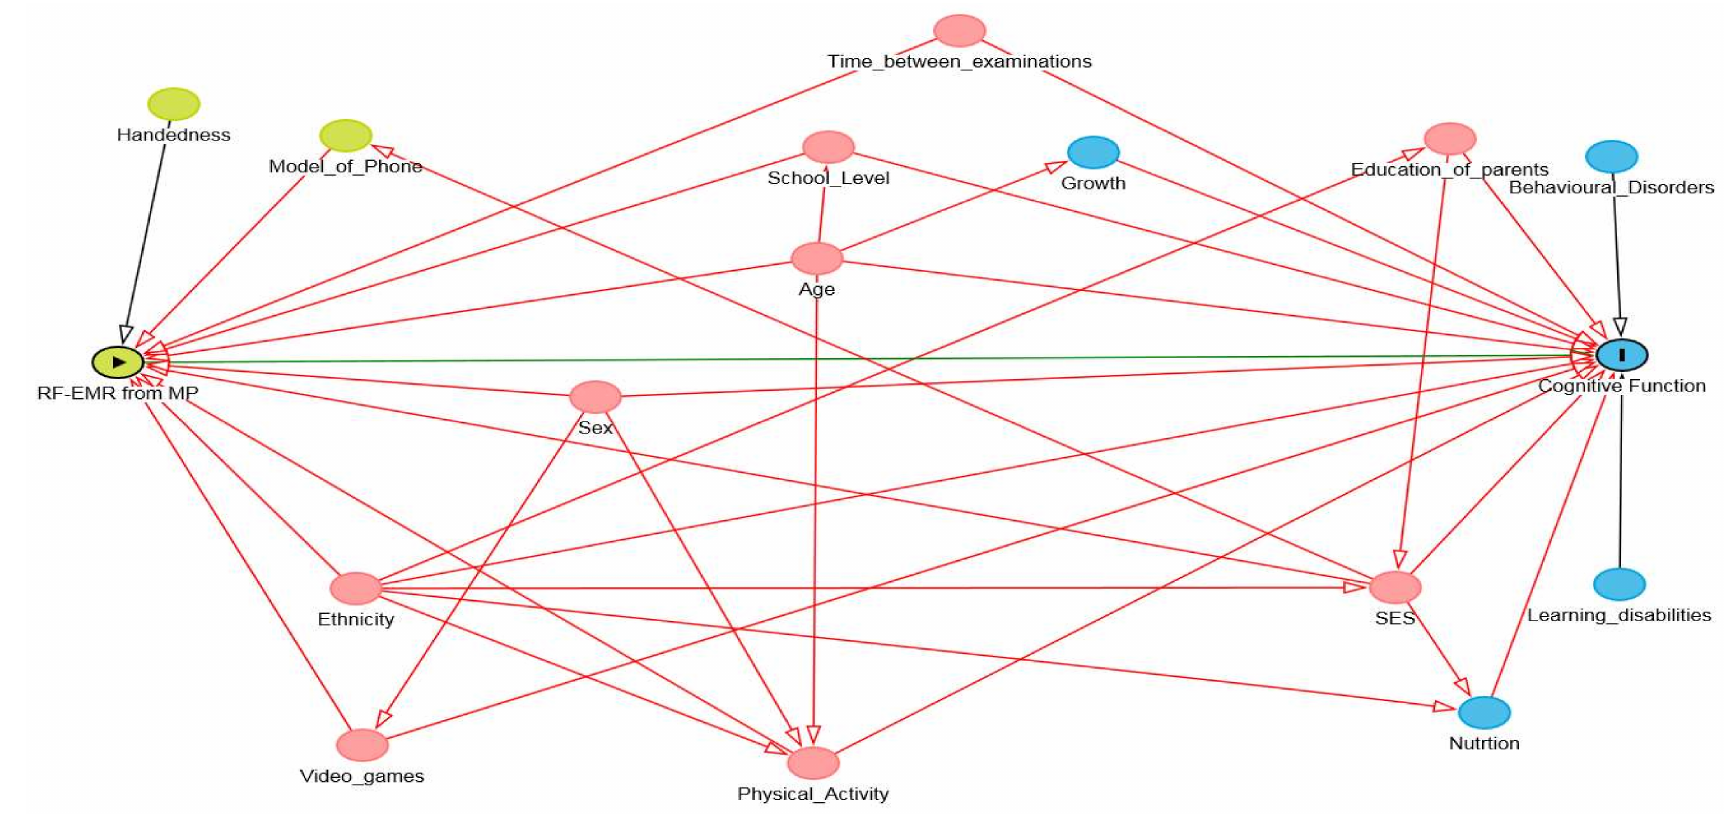
Figure 3. An example of a directed acyclic graph for associations between RF-EMR exposure and cognitive functions. Green variables are ancestors of the exposure. Blue variables are ancesters of the outcome and red variables are ancesters of both exposure and